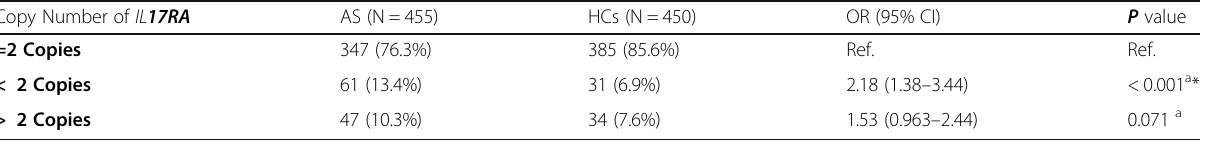
Table 2 Frequency distribution of IL17RA copy numbers in cases and controls and estimation of AS risk. (N